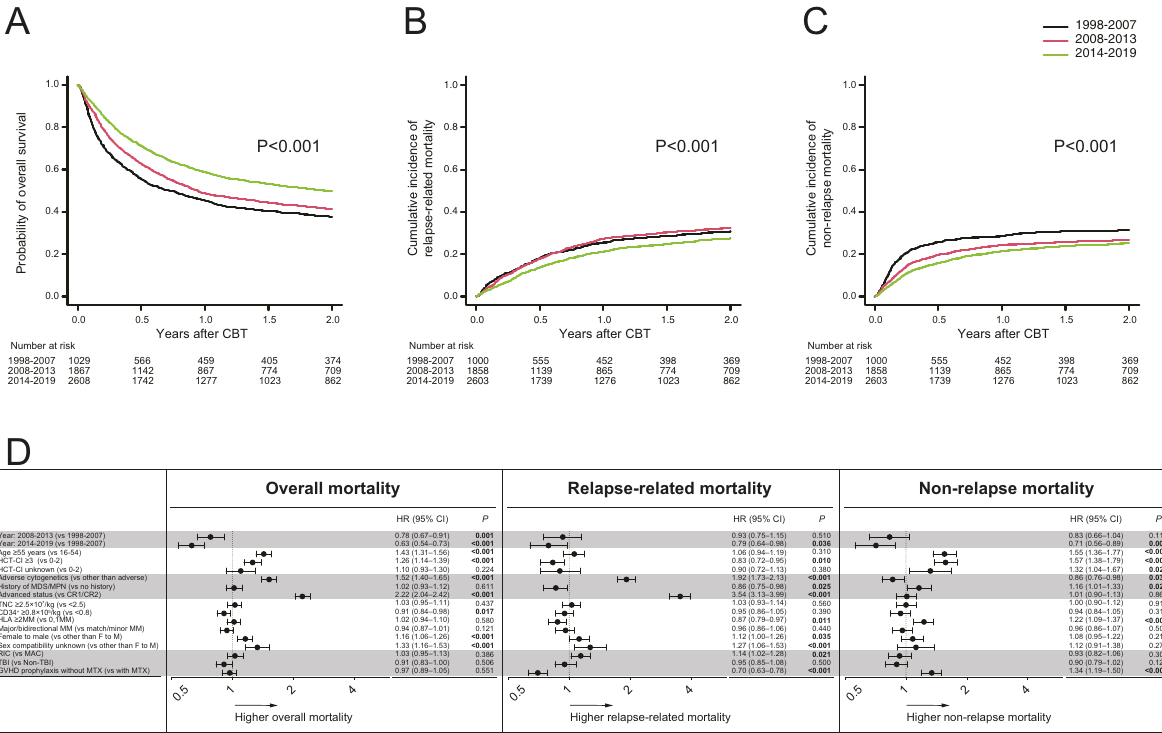
Fig. 1 Overall survival, relapse-related moratlity, and non-relapse mortality after CBT in the entire cohort. The probability of overall survival ( A ) and the cumulative incidences of relapse-related mortality ( B ) and non-relapse mortality ( C ) after CBT according to the three time periods in the entire cohort. Forest plots of the adjusted hazard ratios (HR) and 95% con fi dence intervals (CI) of overall mortality, relapse- related mortality, and non-relapse mortality in the multivariate analysis ( D